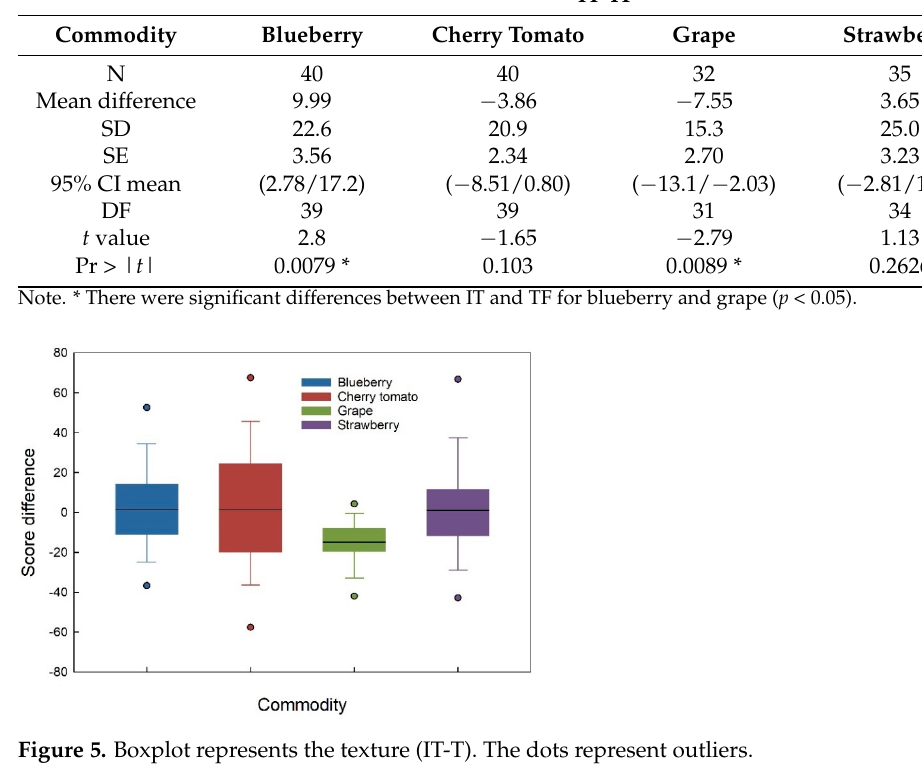
Table 3. Paired t -test comparing mean texture (IT-TF, firmness intensity) score between the images and real produce based on each commodity.